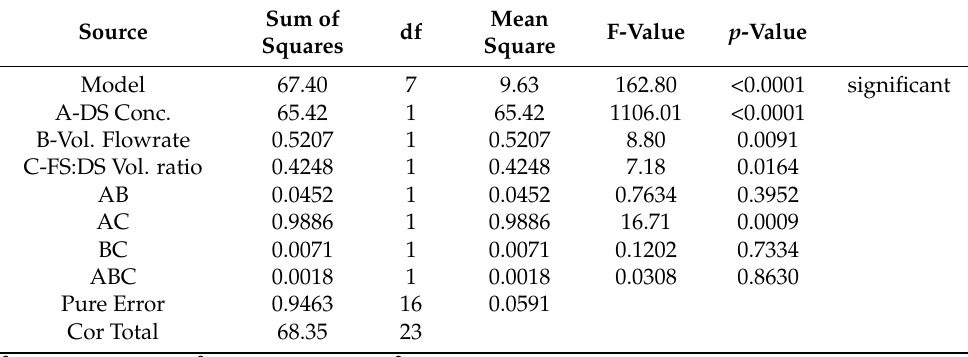
Table 5. ANOVA for average water flux: effect of DS concentration (A), DS volumetric flowrate (B), and FS:DS volume ratio (C).